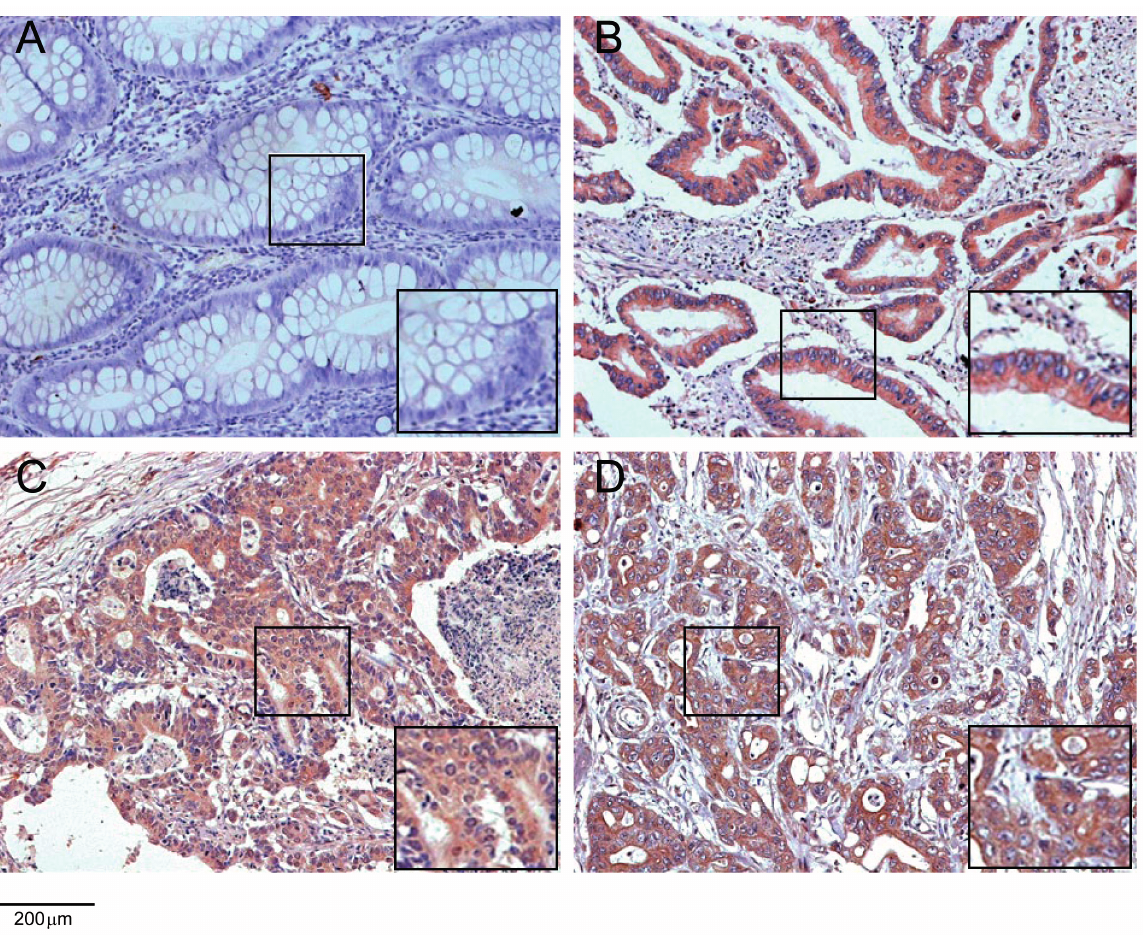
Figure 4. AZGP1 overexpression in colon tumorous tissues validated by TMA analysis. ( A ) Negative AZGP1 expression in normal colonic epithelium; ( B ) Strong AZGP1 staining in well-differentiated colon tumor tissues; ( C ) moderately differentiated colon tumor tissues and ( D ) poorly differentiated colon tumors tissues. Magnification